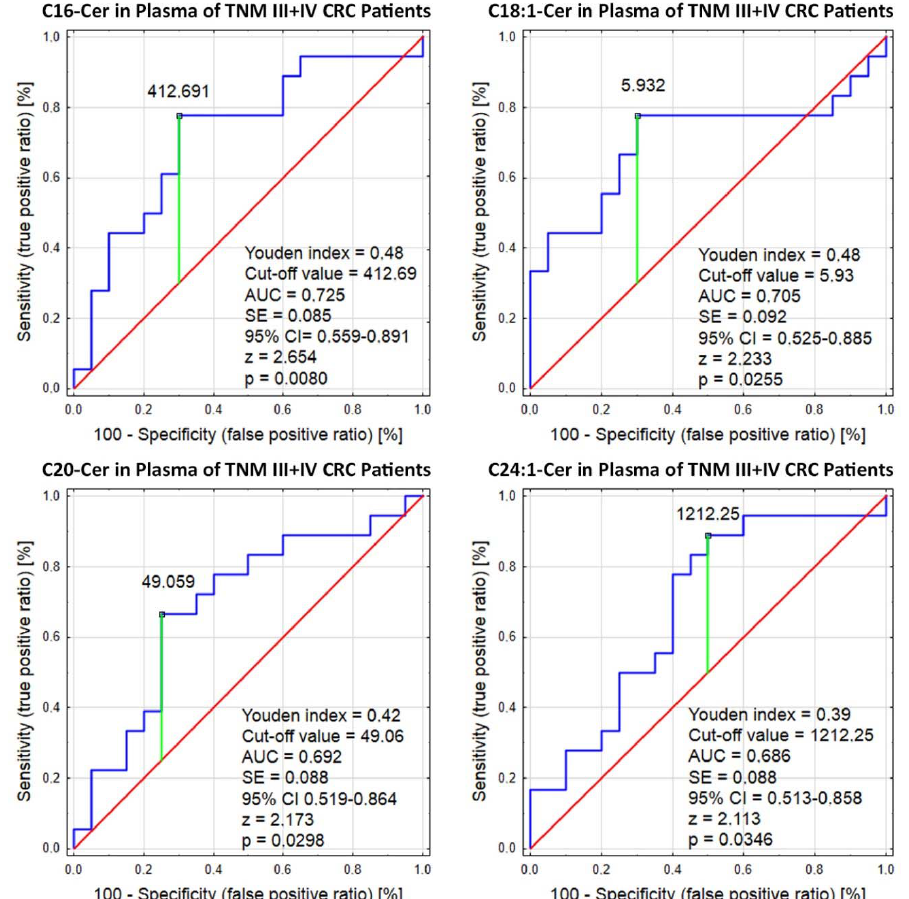
Figure 2. Receiver operator characteristic (ROC) curve analysis of statistically significant plasma sphingolipids (C16:0 ‐ Cer, C ‐ 24:1 ‐ Cer, C18:1 ‐ Cer, and C20:0 ‐ Cer) in patients with advanced CRC sphingolipids (C16:0-Cer, C-24:1-Cer, C18:1-Cer, and C20:0-Cer) in patients with advanced